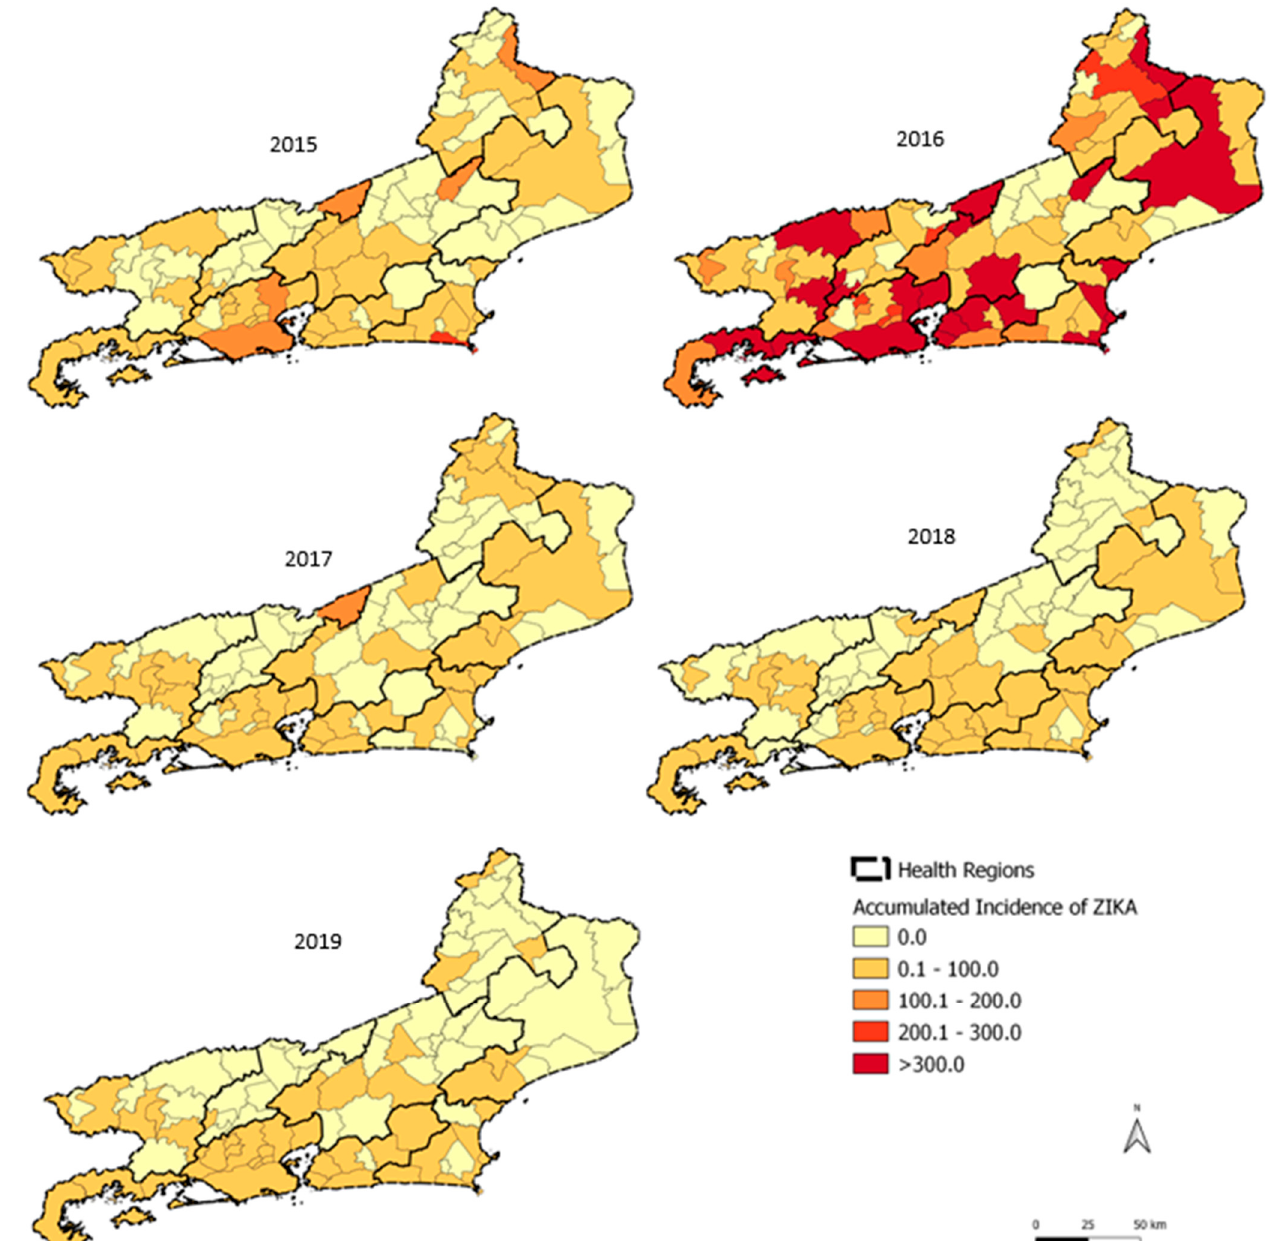
Figure 7. Zika by year of symptom onset in the state of Rio de Janeiro, 2015–2019.